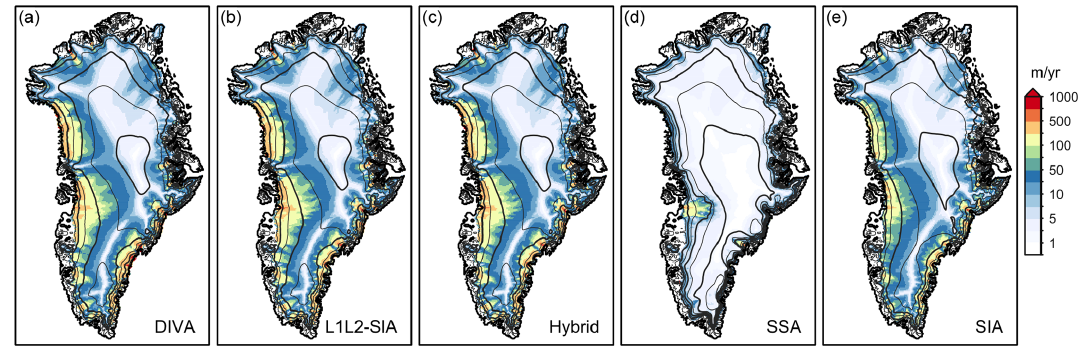
Figure 2. Simulated surface velocity (myr − 1 ) at 8km resolution at the end of the 3kyr simulation using the (a) DIVA, (b) L1L2-SIA, (c) Hybrid, (d) SSA and (e) SIA solvers as implemented in the Yelmo ice-sheet model.